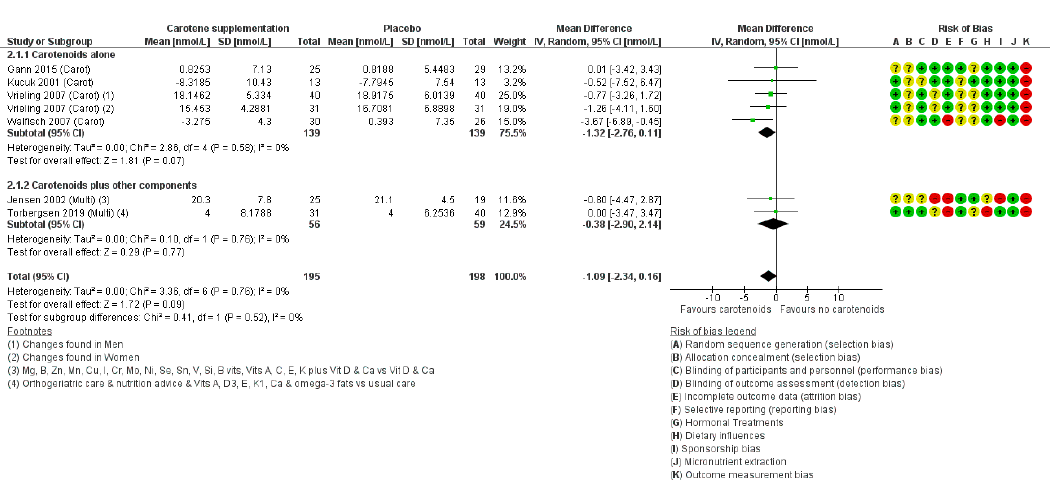
Figure7. Forestplotassessinge ff ectsofincreasingcarotenoids(lycopene)andcarotenoidsamongstother Figure 7. Forest plot assessing effects of increasing carotenoids (lycopene) and carotenoids amongst nutrients on IGF-1 (nmol / L). Carot, carotenoids; multi, multi-nutrient. Please refer to Supplementary other nutrients on IGF-1 (nmol/L). Carot, carotenoids; multi, multi-nutrient. Please refer to Table S5, E to find detailed information on the studies and reference Supplementary Table S5, E to find detailed information on the studies and reference details.